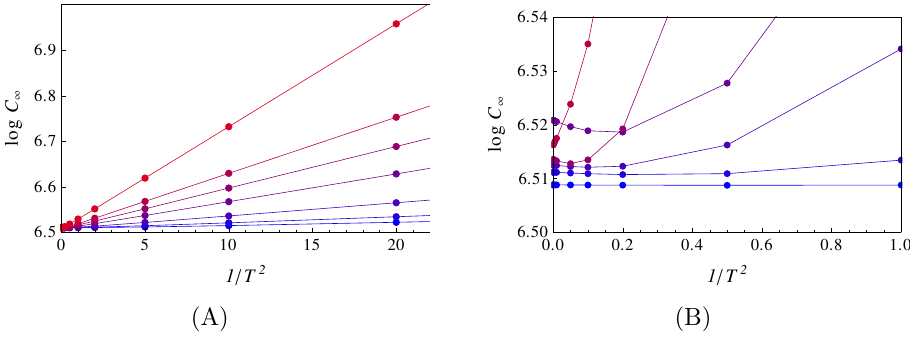
Figure 4. The saturated OTOC C ∞ ( T ) of a pair of dense random operators A and B for the Gaussian orthogonal random Hamiltonian with σ = 0 . 01 , 0 . 05 , 0 . 1 , 0 . 2 , 0 . 4 , 0 . 6 , 0 . 8 (blue to red). In (A), looking at the full range of C ∞ values, it is obvious that the dominant regime is still the exp( c/T 2 ) scaling. However, focusing on the low- σ ensembles (B), we notice the high-temperature growing behavior of the OTOC plateau which is absent for sparse